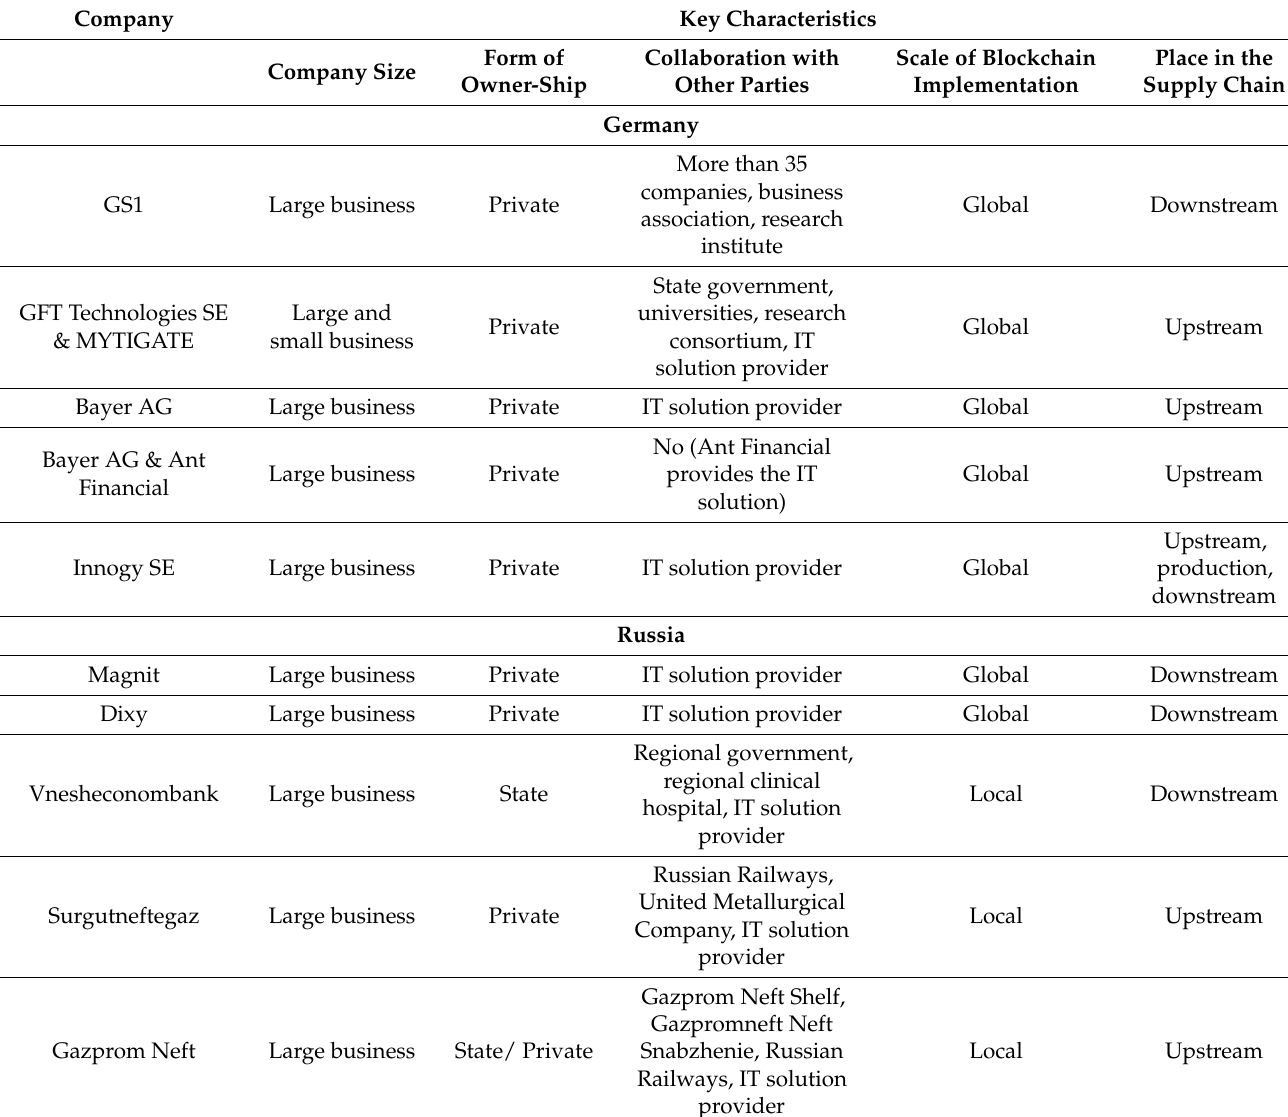
Table 1. The key characteristics of the blockchain implementation